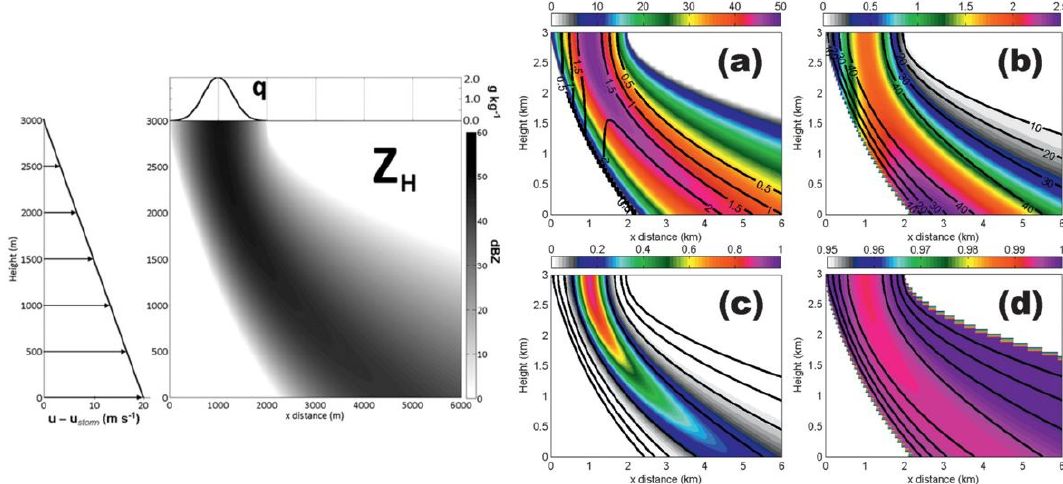
Figure 9. ( Left panel ) Schematic of the two-dimensional wind shear model configuration: ( left ) storm-relative wind profile and ( right ) the domain and resulting Z distribution (shaded; dBZ). The “cloud” rainwater mixing ratio q (g/kg) profile is shown above the domain. ( Right panels ) Results from the two-dimensional wind shear model using the bin formulation: panels show the 2D fields of ( a ) Z H , ( b ) Z DR , ( c ) K DP , and ( d ) ρ hv . Overlaid on ( a ) are the Z DR contours (0.5–2.5 dB in 0.5-dB increments); ( b )–( d ) have Z contours (10–40 dBZ in 10-dBZ increments) overlaid. Adapted from Kumjian and Ryzhkov [84].